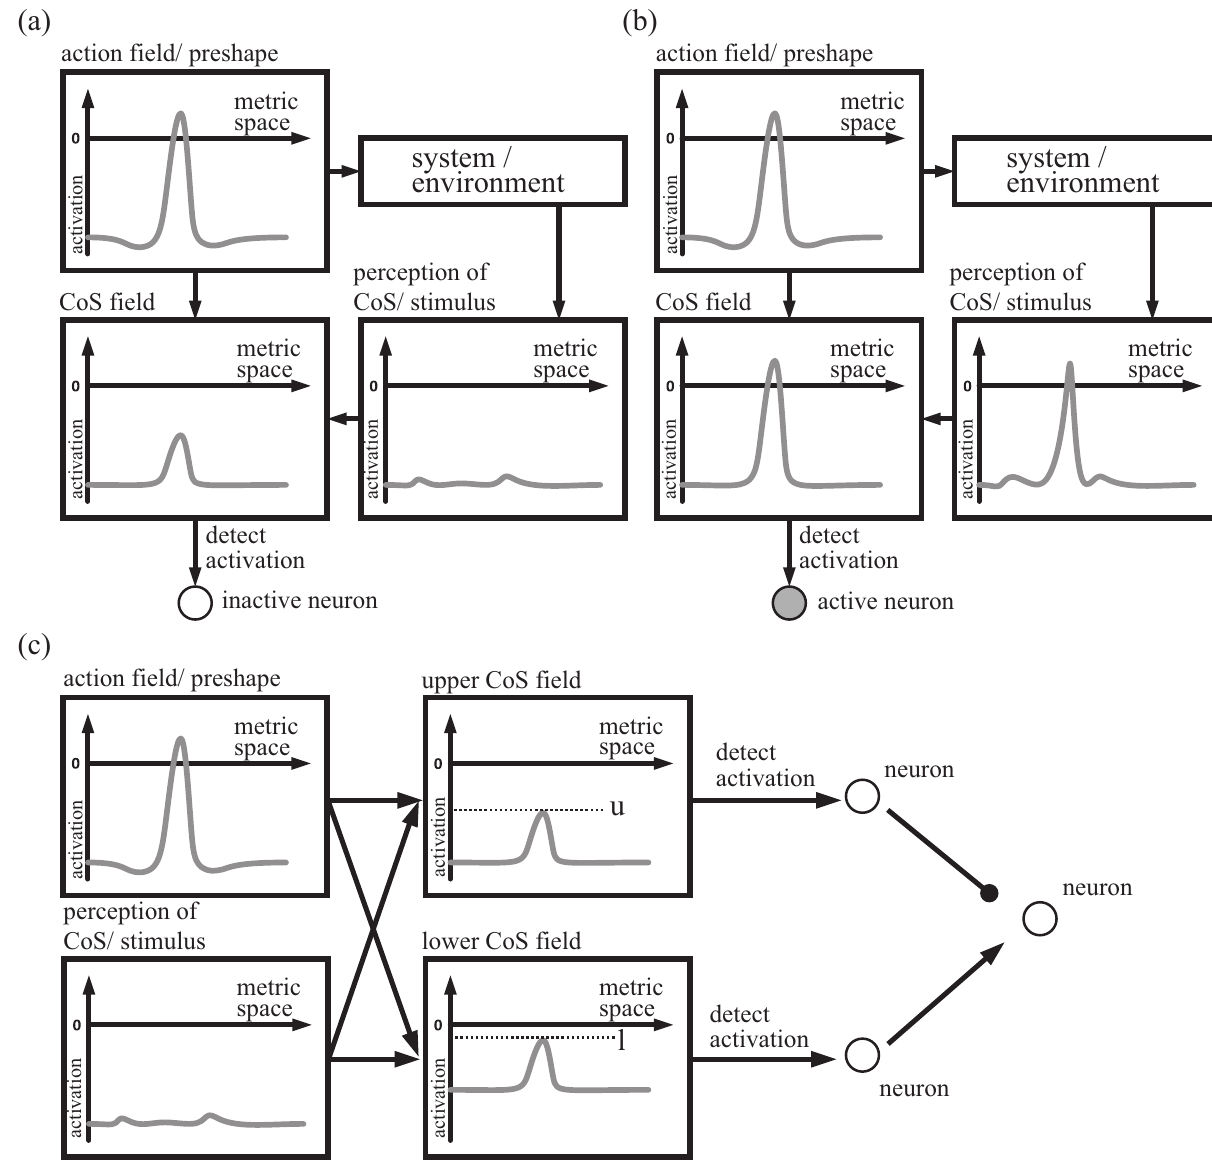
Figure 2. Illustration of the Condition of Satisfaction (CoS) approach. (a) Preshaped CoS field without corresponding input from the Perception of CoS . (b) Matching input resulting in an activation in the CoS field , which can be used to activate a neuron. (c) Illustration of the Range of Satisfaction (RoS) concept. The preshape and stimulus are used as input for both, the lower field and upper field . Further, the range boundaries are illustrated within the